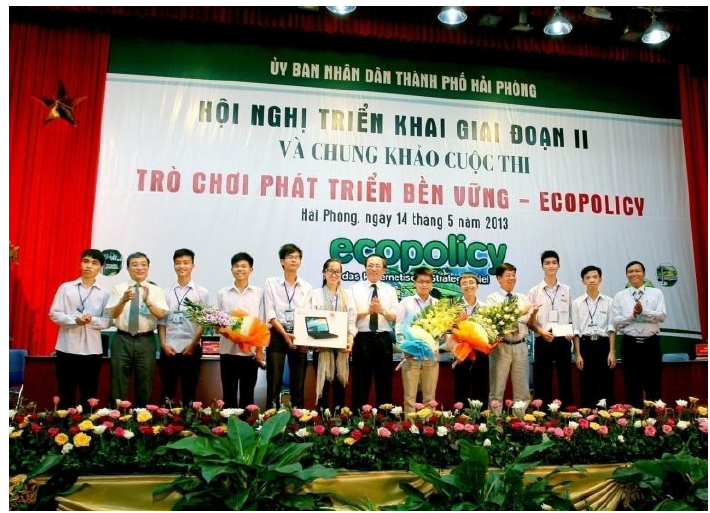
Figure 5. Winning teams at the Haiphong Final